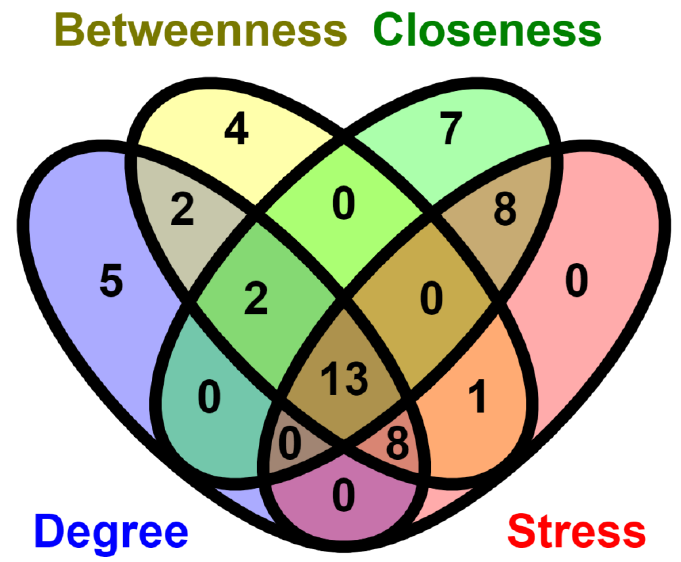
Figure 5. Venn diagram depicting the overlapped nodes in four methods used in Cytohubba. Showing intersections of topological properties.